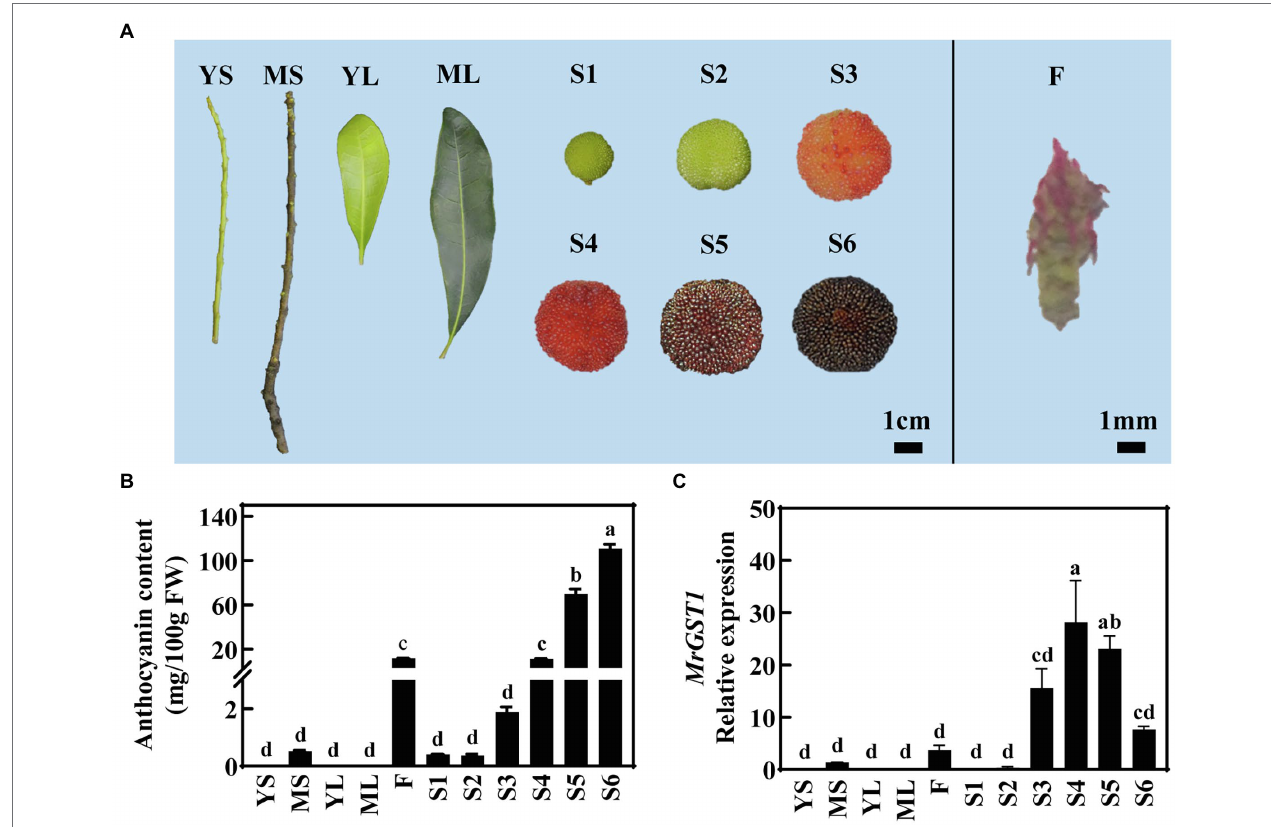
FIGURE 2 | Expression of MrGST1 related to anthocyanin accumulation in different tissues and fruit at different developmental stages of “Biqi” Chinese bayberry. (A) Photo of different tissues, including YS (young stems), MS (mature stems), YL (young leaves), ML (mature leaves), S1 (fruit at 60 days after full-bloom, DAFB), S2 (67 DAFB), S3 (74 DAFB), S4 (78 DAFB), S5 (82 DAFB), S6 (86 DAFB), and F (Flowers). (B) Anthocyanin content. (C) MrGST1 (KAB1211367.1) expression levels. Data were means (±SE) from three independent biological replicates. Same letter indicates no significant difference ( p <